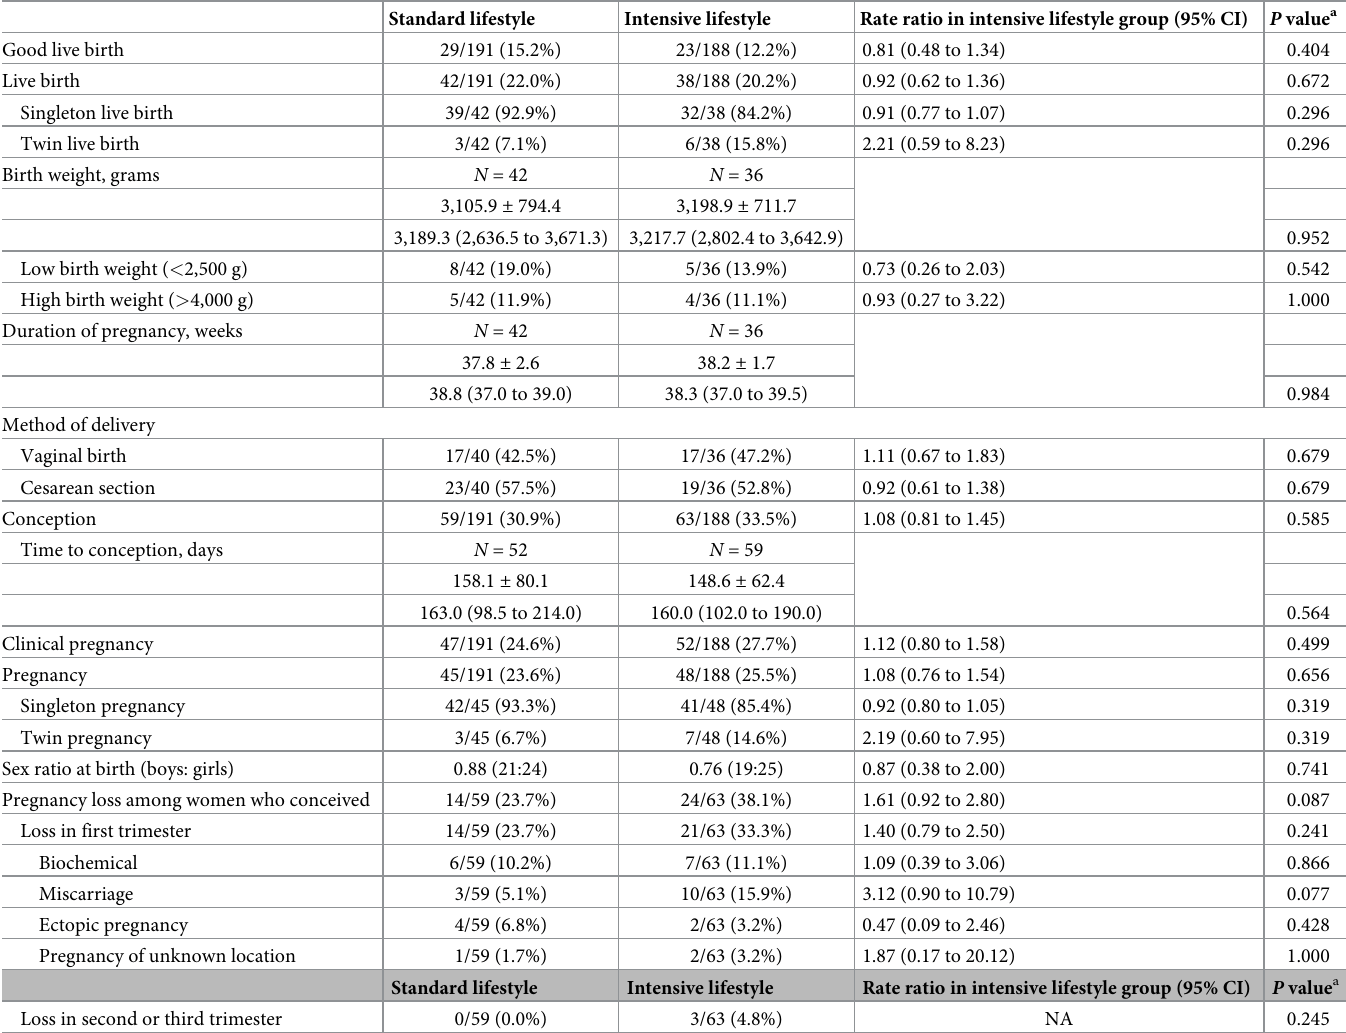
Table 3. Pregnancy outcomes according to intervention